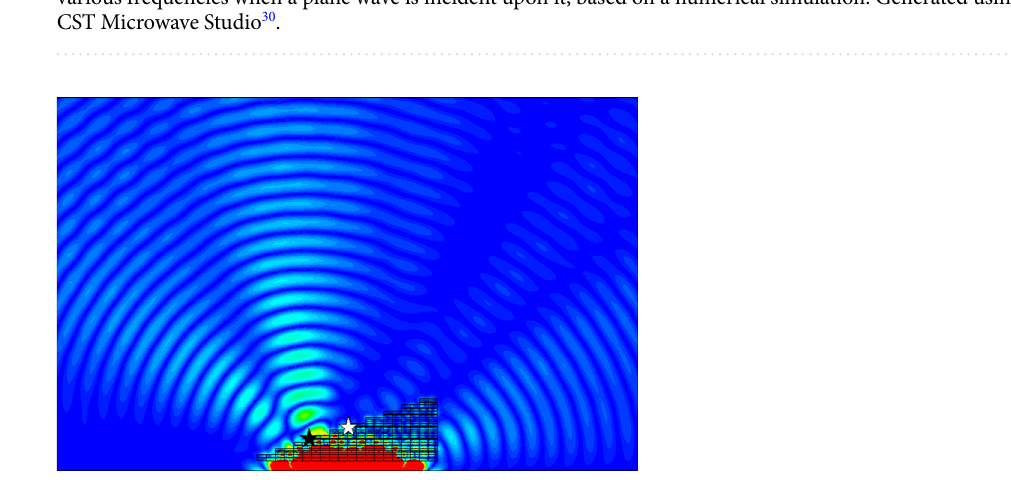
Figure 13. Absolute value of the electric field within and around a prism made of Du et al.’s metamaterial when a plane wave of frequency 0.8 THz is incident upon it, based on a numerical simulation. The white star indicates the center of the expected emerging plane wave, and the black star the position of the actual center of the emerging plane wave. Generated using CST Microwave Studio 30